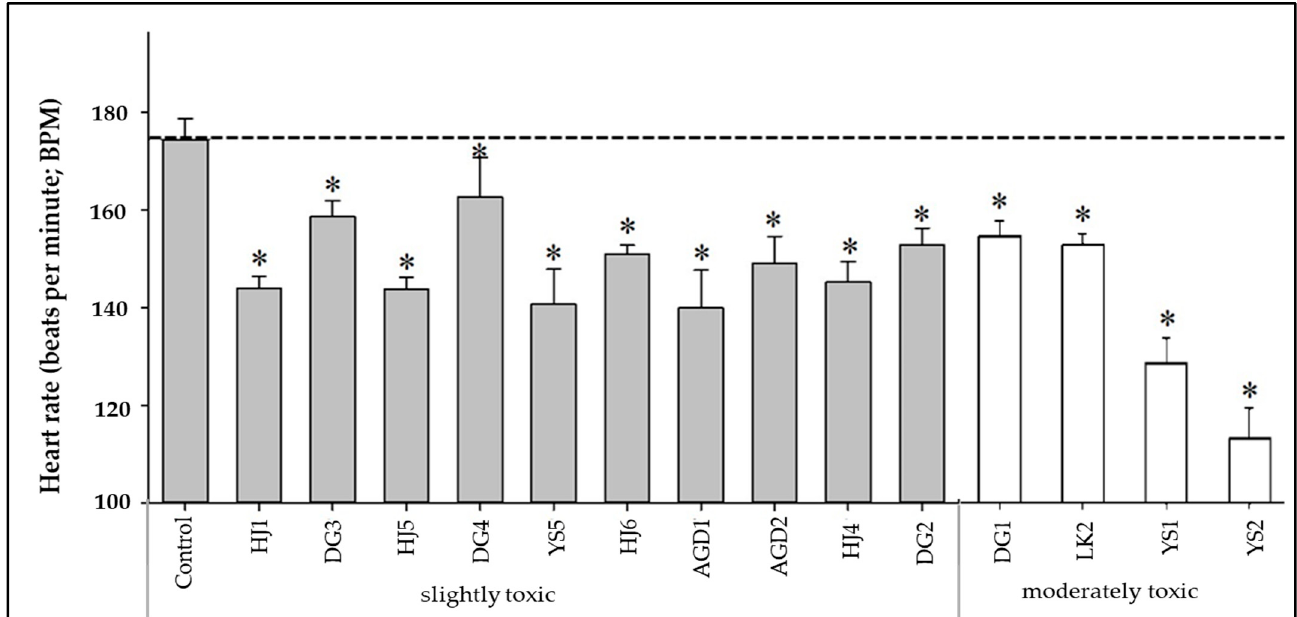
Figure 6. Effect of pollutants from sediment porewater on the heartbeat rate of zebrafish embryos. Hatching rate of zebrafish embryos exposed for 72 h at sampling stations with slightly toxic and moderately toxic porewaters. Error bars represent the standard deviation of the six zebrafish embryos. * p < 0.05 indicates significant differences between the control and exposure groups.